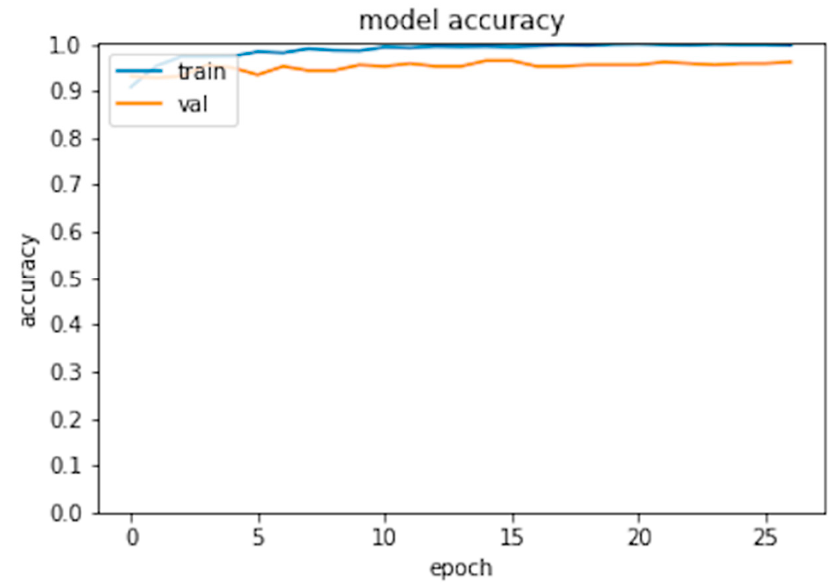
Figure 2. Model accuracy for the training and validation set.